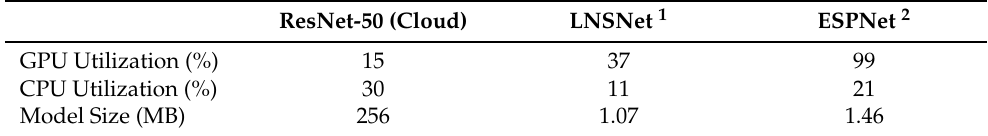
Table 5. Comparison of the cloud model to efficient networks in previous works.